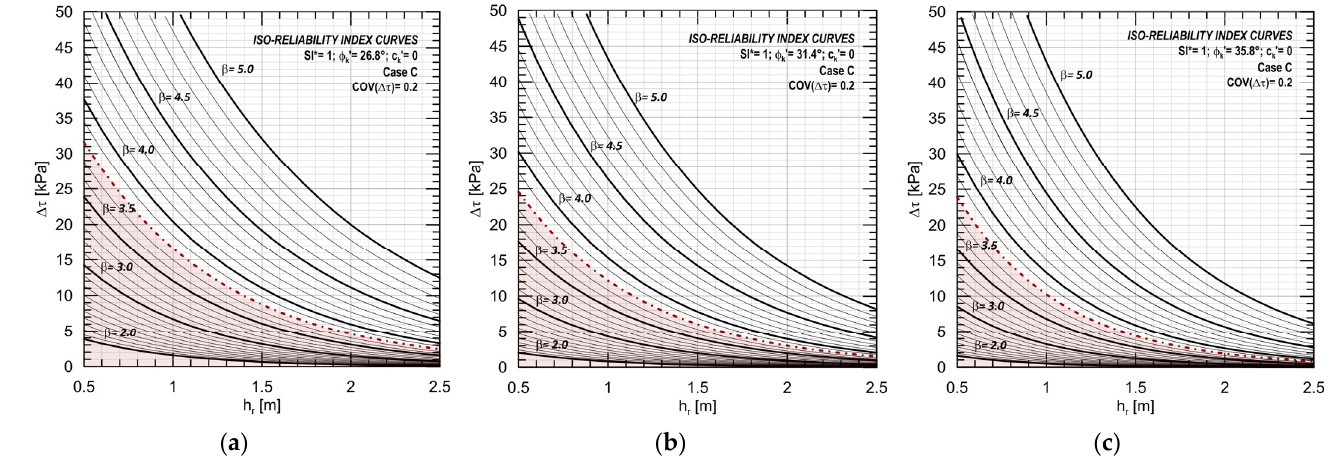
Figure 10. Iso-reliability index curves for varying ∆ τ and h r , for seismic case C and COV ( ∆ τ ) = 20%, Figure 10. Iso ‐ reliability index curves for varying  τ and h r , for seismic case C and COV (  τ ) = 20%, in case of ϕ k ′ = 26.8° ( a ), ϕ k ′ = 31.4° ( b ), and ϕ k ′ = 35.8° ( c ), respectively. in case of φ k (cid:48) = 26.8 ◦ ( a ), φ k (cid:48) = 31.4 ◦ ( b ), and φ k (cid:48) = 35.8 ◦ ( c ),